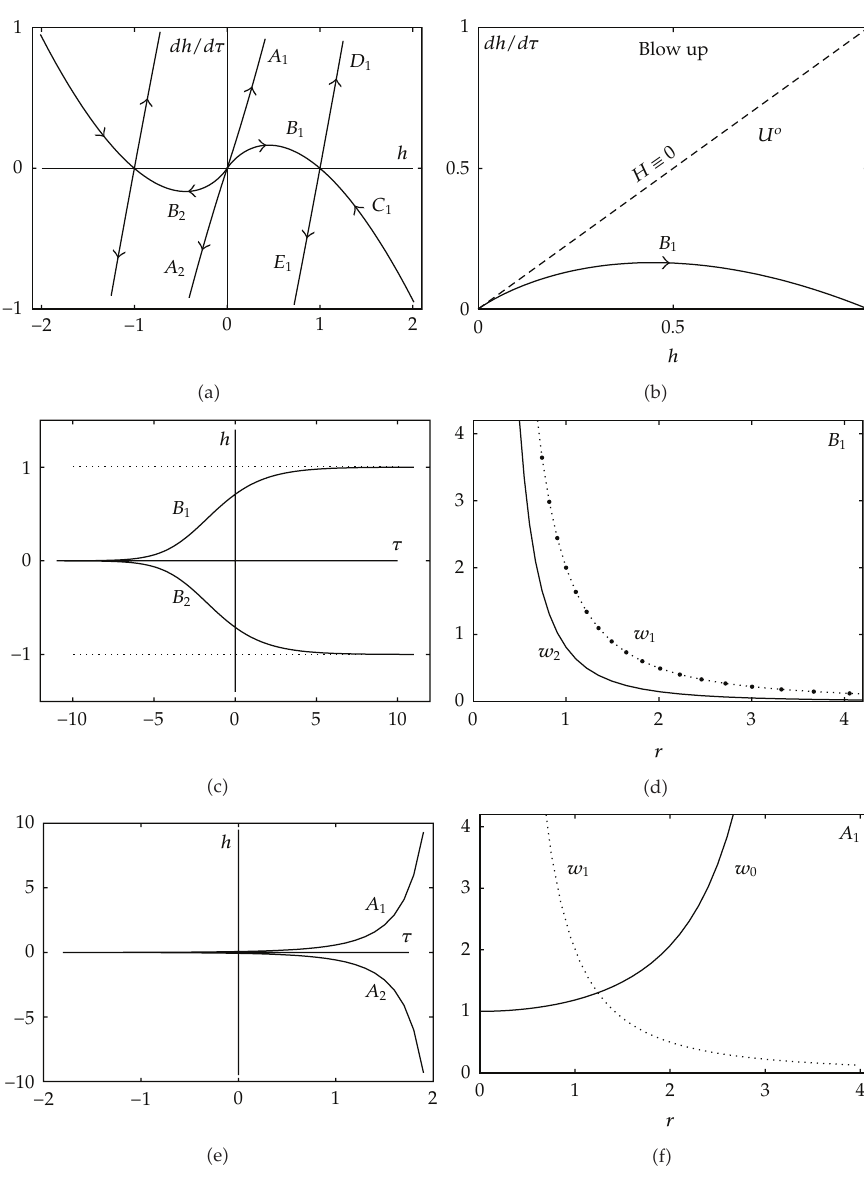
A B B w components along A 1 , 2 , 1 , 2 and 1